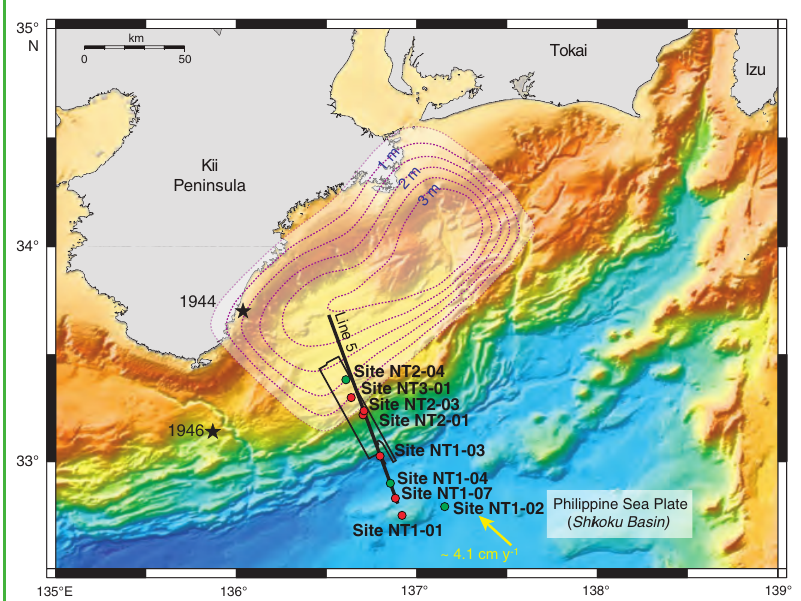
Figure 1. Bathymetric map of Kumano Basin region, with Kikuchi et al. (2003) inversion of the co- seismic rupture area of the 1944 Tonankai earthquake (gray contours ), 3-D multichannel seismic survey area shown (bold black outline), and location of planned drill sites identified. Deep-penetration Multi Channel Seismic (MCS) Line 5 (thick black line) is shown in Fig. 2 with drill sites projected onto